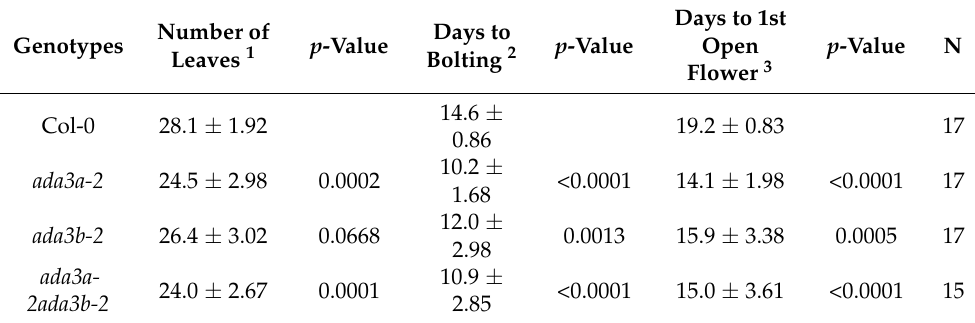
Table 2. ADA3a and ADA3b are involved in the vegetative to reproductive transition. Plants were moved from SD to LD, and the number of leaves, days to bolting, and days to first open flower were counted.